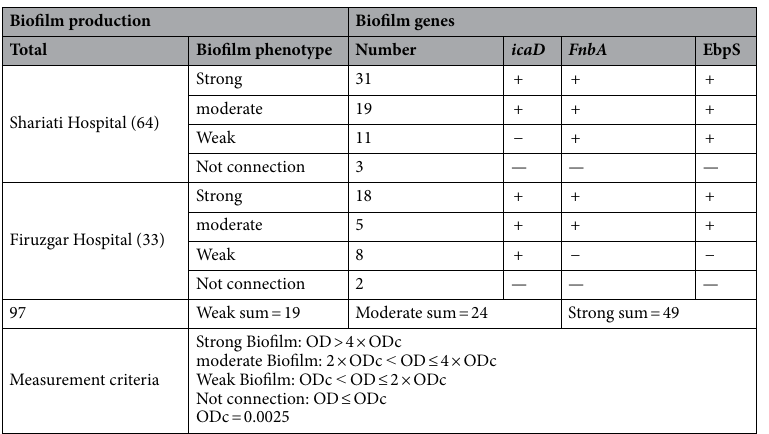
Table 4. Screening and determining the frequency of MRSE and MDR in biofilms from various